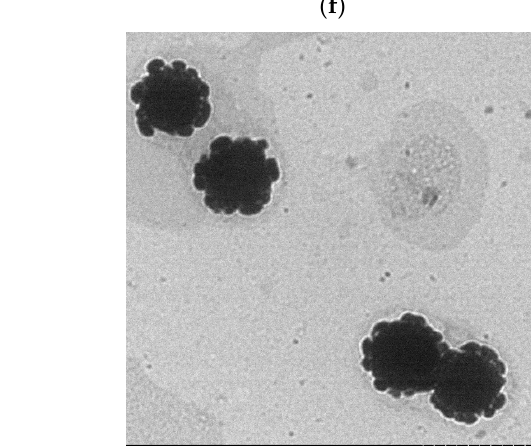
Figure 2. Transmission electron microscopy (TEM) images of Clitoria ternatea petal (CTP) liposomes prepared by different homogenization types. ( a ) Magnet stirring; ( b ) Ultrasonic bath; ( c ) Probe ultrasonication; ( d ) HPP at 300 MPa; ( e ) HPP at 400 MPa; ( f ) HPP at 600 MPa.